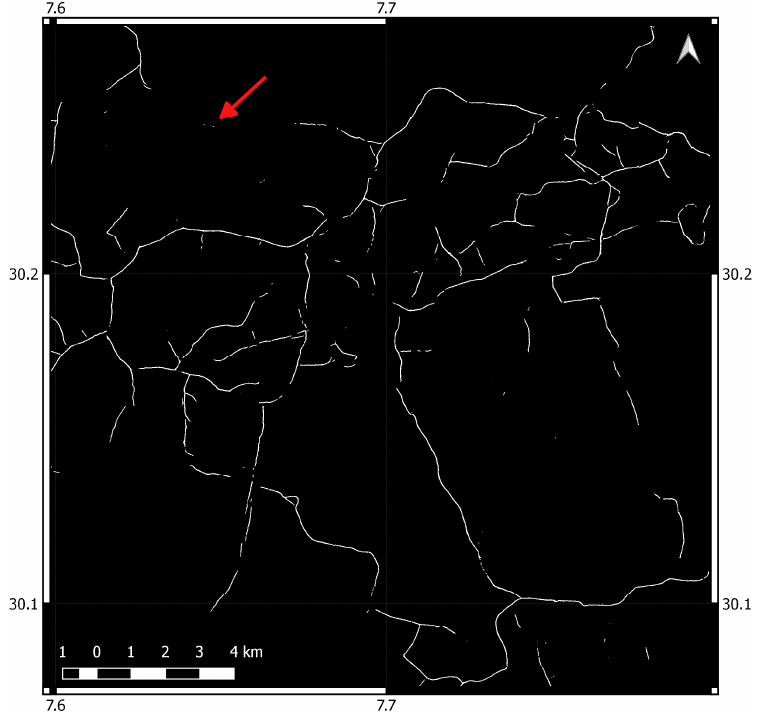
Figure 12. Detected roads for a randomly selected 0.2 × 0.2 degree subset over the Grand Erg Oriental AOI. White lines correspond with detected roads. The red arrow points to an example of a missed detection, perhaps due to mixed infrastructure.